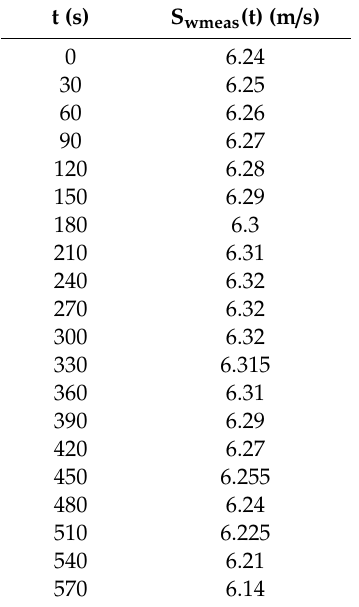
Table 1. Measured wind speed values over